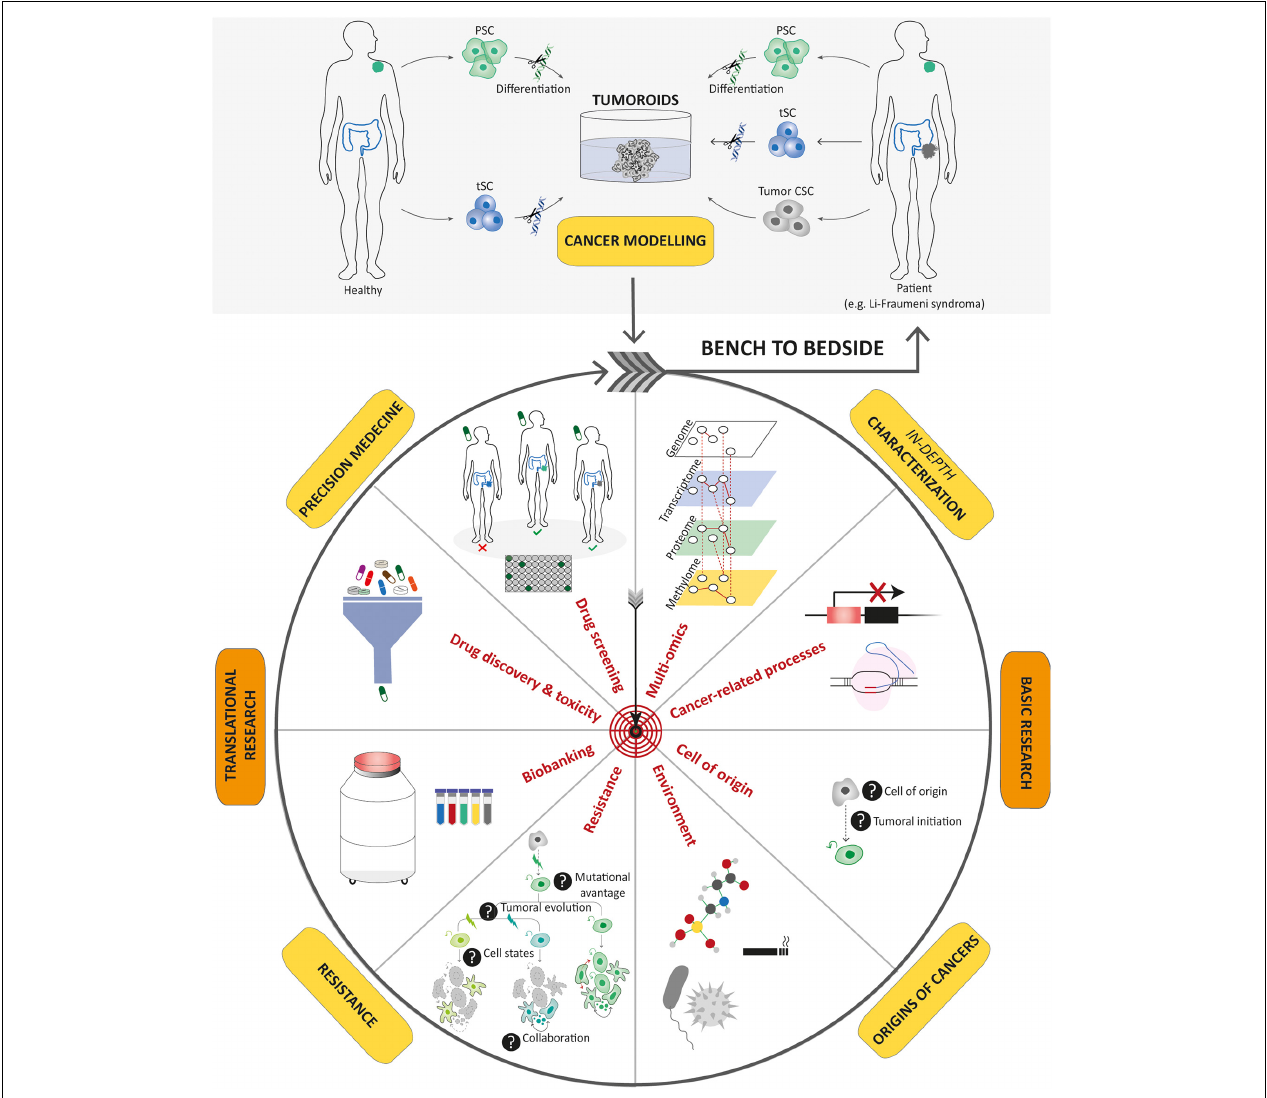
FIGURE 5 | Potential applications of tumoroids in the field of cancer research. Tumoroids can be derived from PSCs and tissue-specific SCs after introduction of cancer-associated genetic alterations, or directly from tumor samples. These resulting tumoroids represent cancer models and can be profiled by multi-omics integrative analyses to decipher new oncogenetic processes. In basic research, tumoroids can be used to study cancer initiation and its related processes such as the understanding of the cell-of-origin and the links between tumorigenesis and infectious agents or environmental factors. In addition, tumoroids can be used to identify the biological underpinnings of tumor progression and resistance to treatments. Biobanks of tumoroids, in which samples obtained from patients are stored as a resource for future research, can promote the discovery of new cancer drugs and guide optimized therapeutic strategies for an individual or group of stratified patients by predicting drug responses. To conclude, tumoroids have the potential to translate scientific knowledge from bench to bedside with scientific discoveries being swiftly returned to the